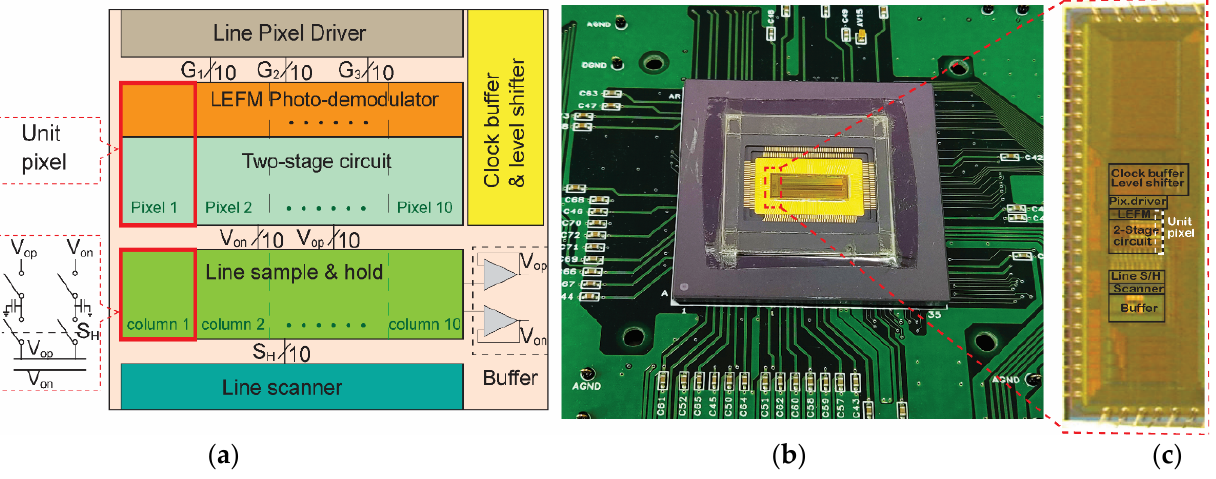
Figure 10. ( a ) System block diagram of the proposed SRS chip architecture. ( b ) Photo of the chip mounted on PCB. ( c ) Photomicrograph of the fabricated SRS chip.